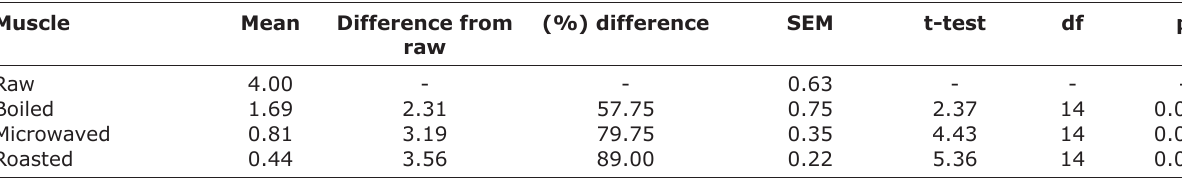
Table-3: Comparison of inhibition zones between raw liver and different cooking methods at pH 6.0.